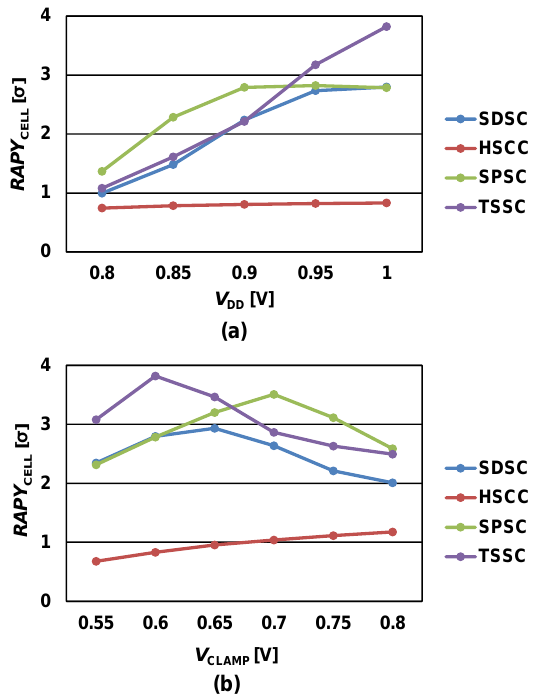
Figure 6. RAPY CELL of SDSC, HSCC, SPSC, and TSSC with respect to ( a ) V DD and ( b ) V CLAMP . Figure 7a illustrates the RAPY CELL values of the SDSC, HSCC, SPSC, and proposed TSSC with respect to the TMR of MTJ when V DD is set to 1 V and V CLAMP is set to 0.6 V. The temperature range was set in the range from − 45 to 90 °C and the worst case was chosen for RAPY CELL calculation. TMR is calculated as ( R 1 − R 0 )/ R 0 and ideally assumes a high values because it influences the sensing speed, read margin, and noise margin of the memory cell. However, the SCs for STT-MRAM must be built to compensate for process- related fluctuations in the TMR value. As shown in Figure 7a, for low sensing current applications, even when the TMR value is decreased to 60%, the proposed TSSC maintains a greater RAPY CELL value compared to existing SCs. Figure 7b plots the RAPY CELL as a function of sensing time when V DD was set to 1 V and V CLAMP was set to 0.6 V. Because the TSSC uses a two-phase sensing operation for the timing-split-based DRV technique, it re- quires sufficient time for charging and discharging. Thus, a sharp increase in RAPY CELL can be observed at approximately 8 ns, and the RAPY CELL value is saturated at approxi- mately 14 ns. The existing designs are not sensitive to the sensing time compared to the proposed TSSC, which provides more accurate sensing at the expense of increased sensing times. As mentioned earlier, the TSSC exploits the gate capacitance of the PLD, POR, POD, and PLR transistors to accumulate charge during P1, which raises the question of whether the capacitor-less design is better than using a capacitor. Figure 8 shows the TSSC RAPY CELL value with respect to the additional capacitor capacitance when two capacitors are added at the gates of the PLD and PLR. The RAPY CELL value increases until the addi- tional capacitor capacitance reaches 2 fF but the increment is insignificant and starts to decrease as the capacitance increases further because of the limited sensing time. Moreo- ver, if a capacitor is added to the design, the sizes of all transistors need to be reduced in terms of iso-area, which results in a decrease in the gate capacitance and performance degradation. Accordingly, Figure 8 indicates that the gate capacitances of PLD, POR and POD, PLR pairs are sufficient for the TSSC to accumulate charge during P1 to mirror the data current during P2. Table 1 summarizes the simulation results and compares the proposed TSSC with conventional SCs. The simulation to calculate the average power consumption ( P AVG ) used and the V CLAMP and R ref values are presented in Figure 5. In both states 0 and 1, the TSSC